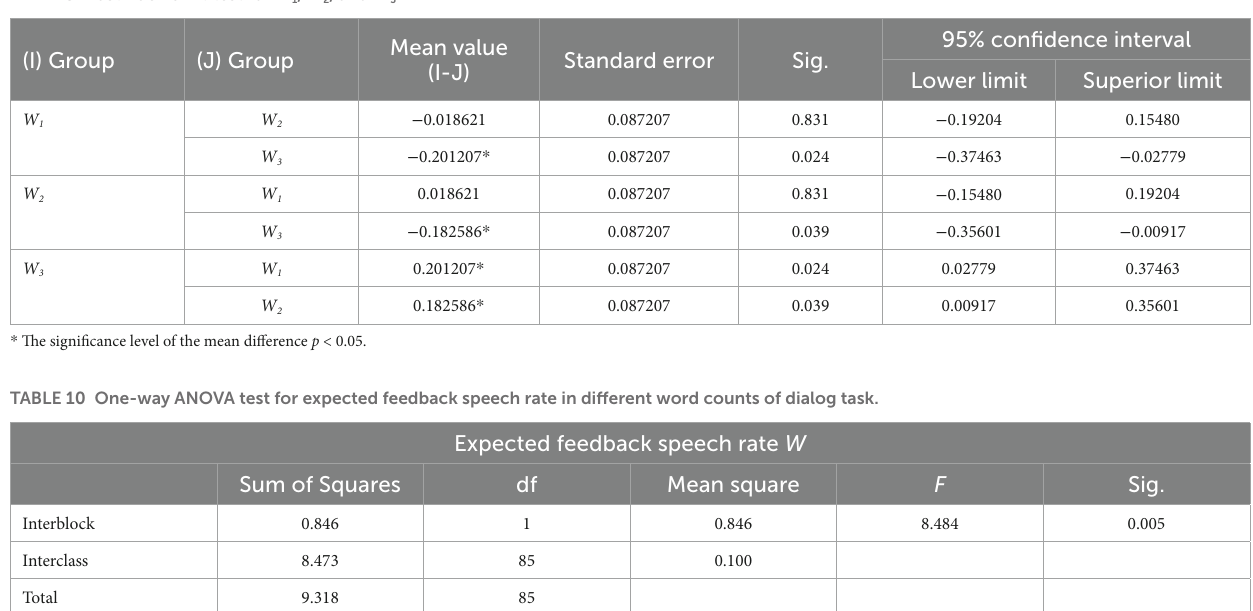
TABLE 9 Post hoc LSD- t test for W 1 , W 2 , and W 3 .